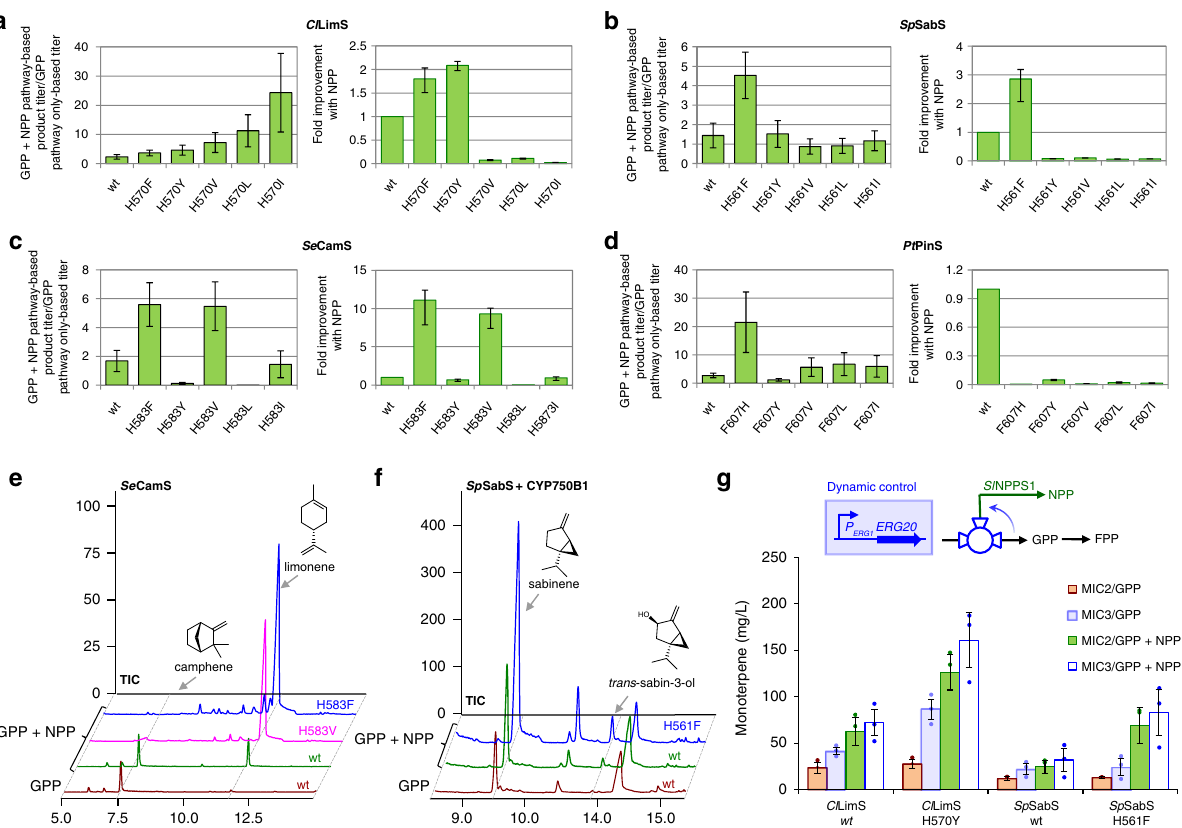
Fig. 5 Monoterpene pro fi le of the terpene synthase variants. Variants of Cl LimS ( a ), Sp SabS ( b ), Se CamS ( c ), and Pt PinS ( d ), carrying different substitutions in the residue homologous to Sf CinS1(F571), were analyzed in yeast cells producing NPP versus non-NPP-producing cells. On the left-hand side of panels a – d , the bar charts show the ratio of the total monoterpene production titer when both the NPP and GPP pathways are present divided by the titer of monoterpene production by the same variant when only the GPP pathway is present. The bar charts on the right-hand side of panels a – d show the total monoterpene titer obtained by each mutant synthase when the NPP pathway was present in comparison to the corresponding wild-type enzyme titer (normalized to 1), indicating the overall ef fi ciency of each enzyme variant. e Se CamS variants H583F and H583V switch speci fi city from a camphene synthase to a highly ef fi cient limonene synthase. f The overall improvements in pathway performance enable the introduction of an additional downstream modi fi cation step. Yeast cells co-expressing Sp SabS and CYP750B1 produce detectable amounts of trans -sabin-3-ol only when the NPP pathway is present. Replacement of wild-type Sp SabS by the NPP-speci fi c variant Sp SabS(H561F) improved trans-sabin-3-ol synthesis even further. g Introduction of P ERG1 upstream of ERG20 in strain MIC3 installs dynamic control of fl uxes through Erg20p. In combination with the NPP-speci fi c variants Cl LimS(H570Y)